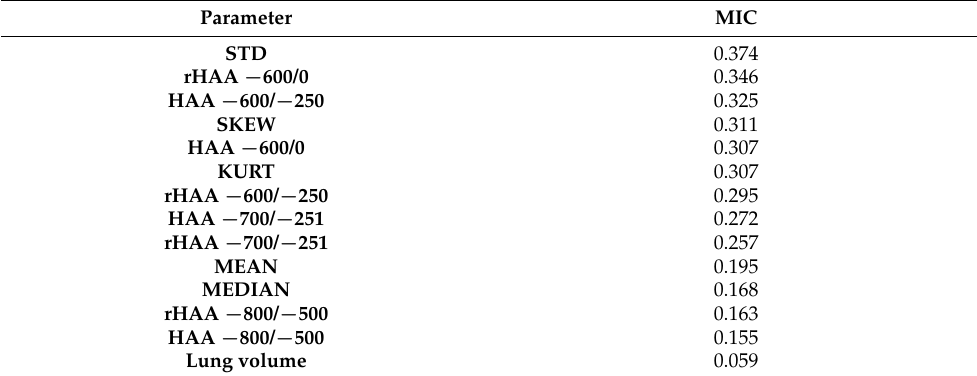
Figure 2. Mean histograms for NECT and CTPA. Mean histograms (black line) for NECTs ( a , b ) and CTPAs ( c , d ) with grey areas indicating variance (2SD). HU values on the x -axis, frequency on the y -axis. The differences in mean histogram curves between the healthy lung group and the AP group are significant for NECTs ( a , b ) regarding all histogram parameters and HAA/rHAA. Differences for CTPAs are subtle ( c , d ). Abbreviations: NECT = non-enhanced computed tomography. CTPA = computed tomography pulmonary angiogram. AP = atypical pneumonia. HAA = high attenuation area. rHAA = relative high attenuation area. SD = standard deviation. Table 3. Potential of imaging biomarkers to separate control vs. AP in